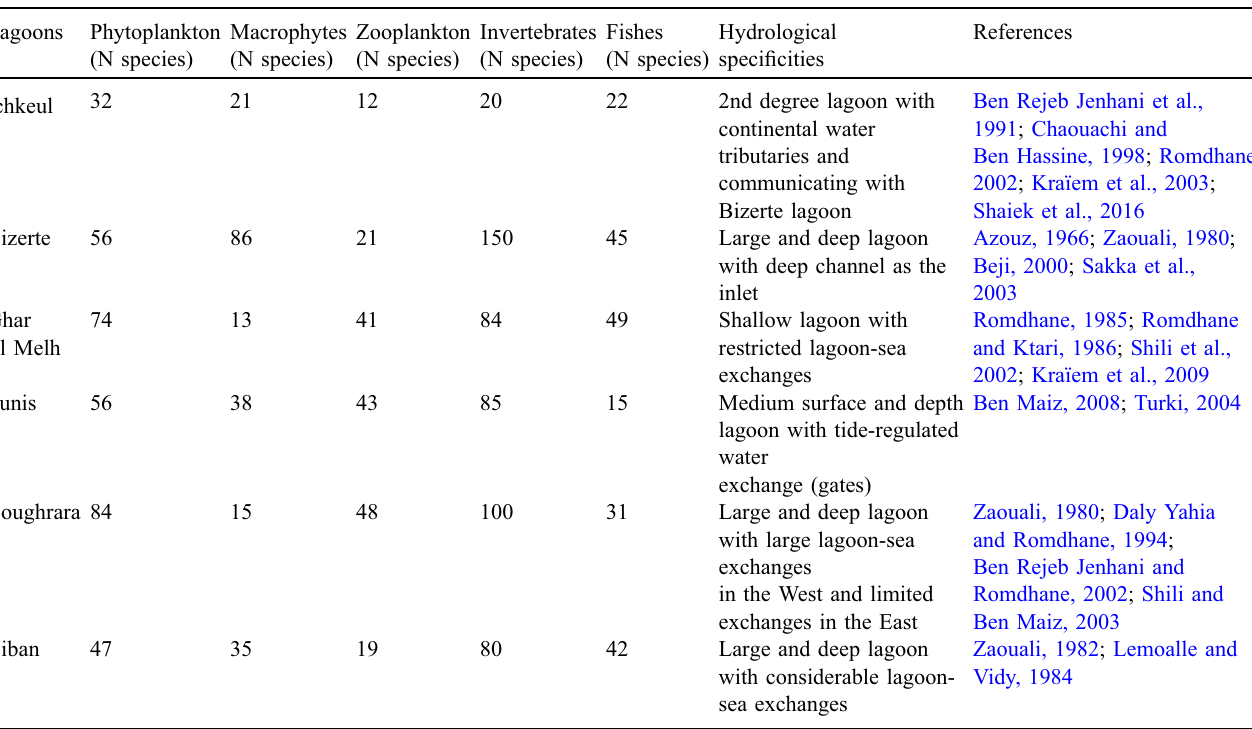
Table 3. Tunisian Lagoon biodiversity.